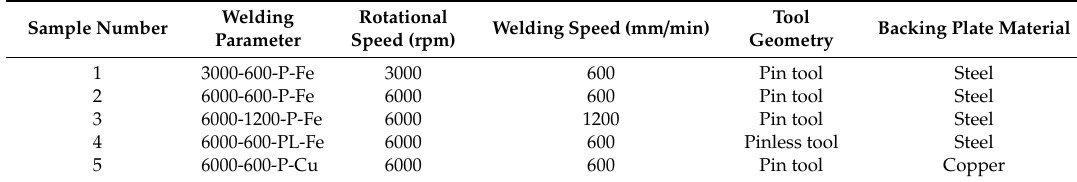
Table 1. Welding